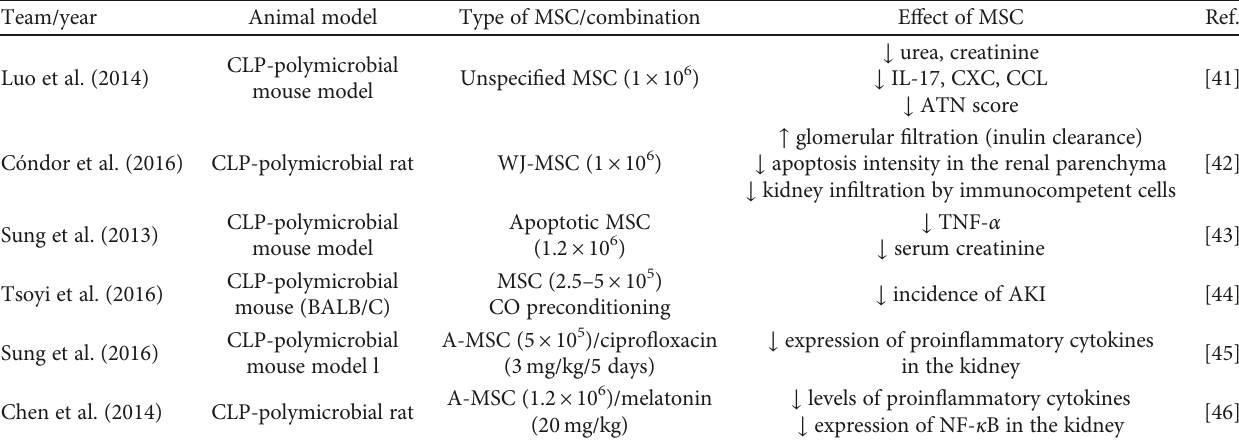
Table 2: Preclinical models of S-AKI and the e ff ect of